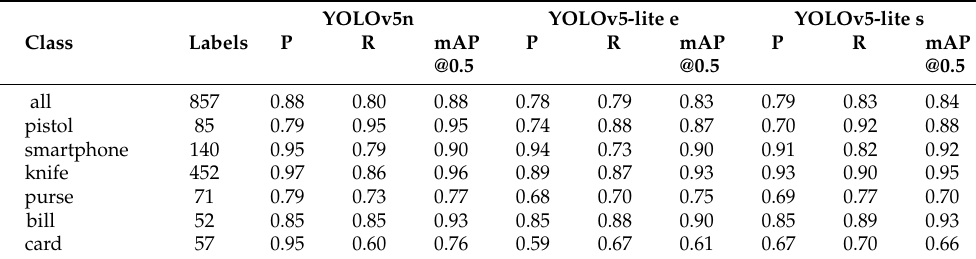
Table 2. Testing results of object detection algorithms.